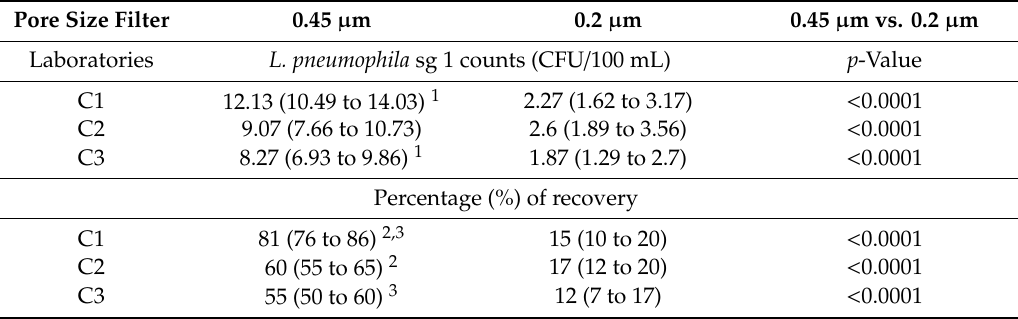
Table 1. Legionella pneumophila sg 1 experiment: averages and 95% confidence intervals for each laboratory and type of membrane filter. p -values from the generalized model were adjusted according to